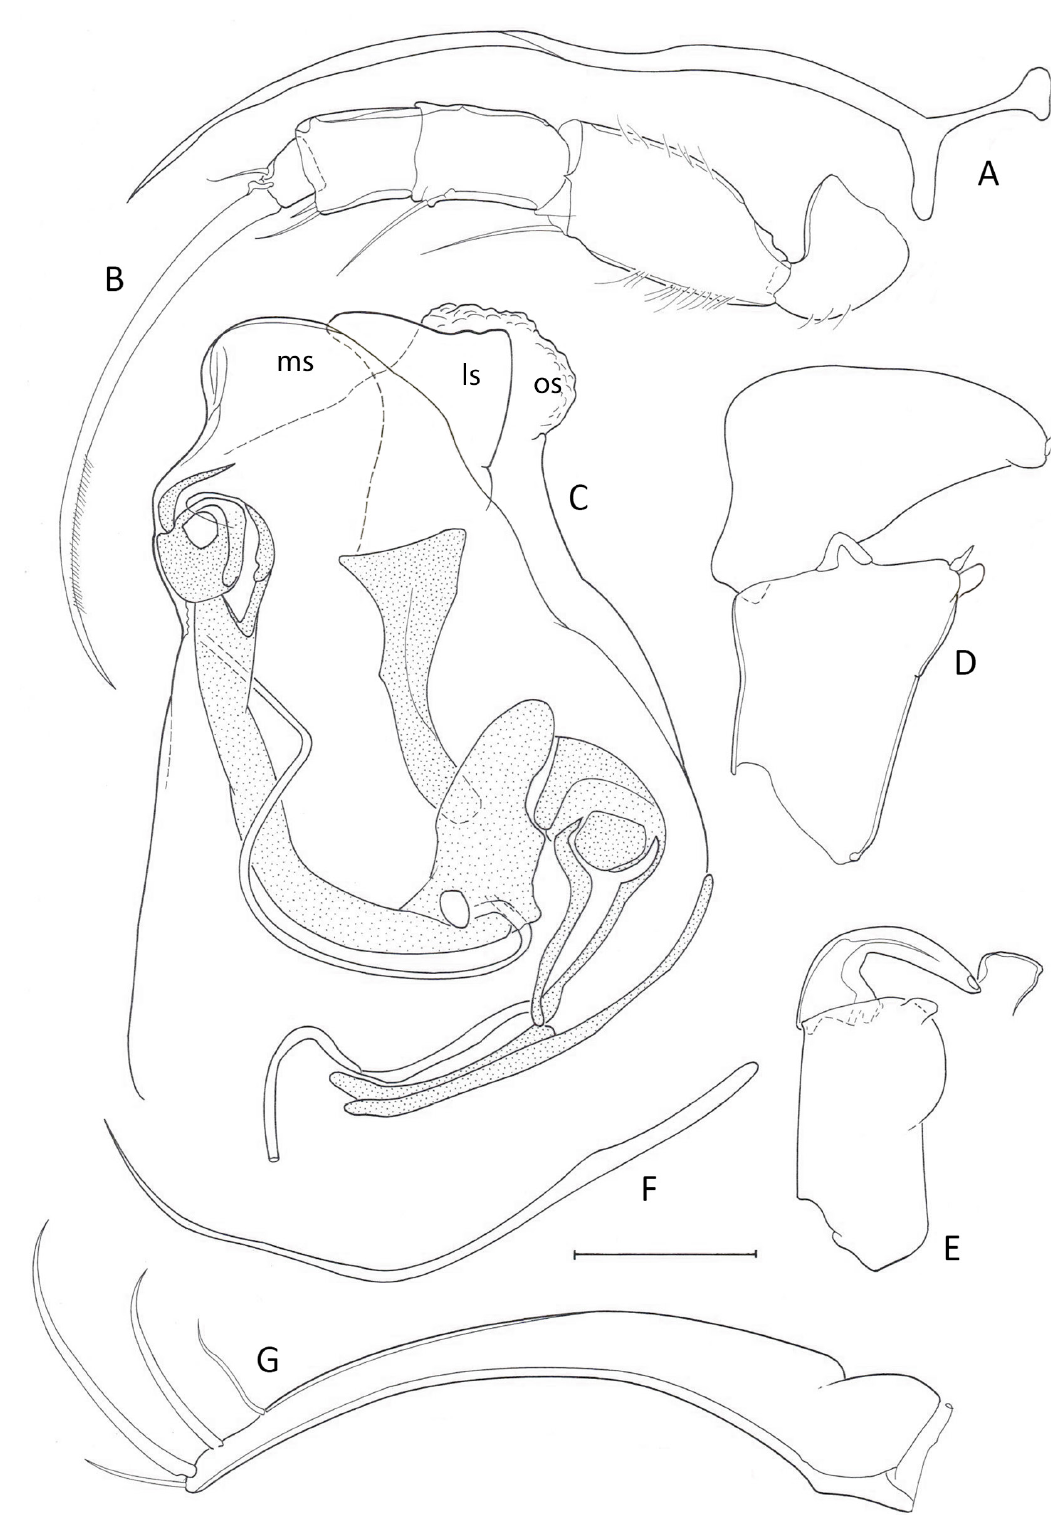
Fig. 7. A–B . Patcypris outback gen. et sp. nov., Lake Maitland (type locality), ♂, holotype (WAM 67184). A. CR attachment (note: the bifurcation to the right is the basis of the CR itself). B. T2. – C–G . Trilocypris horwitzi gen. et sp. nov., Lake Austin (type locality), ♂, holotype (WAM 67199). C. Hp. D. Rpp. E. Lpp. F. CR attachment. G. CR. Scale = 92